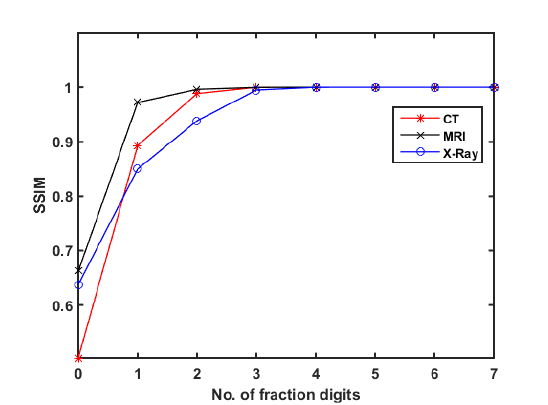
Figure 8. SSIM vs Number of the fraction digits for the proposed